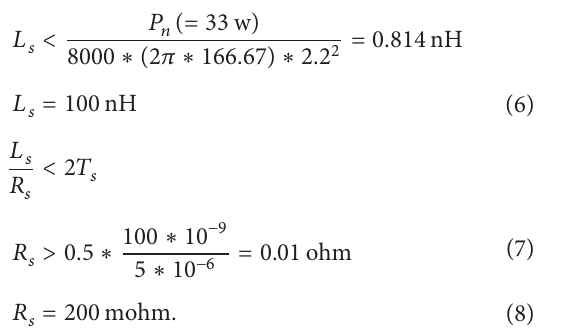
Figure 19: The 3-phase motor currents (with LCL filter and capacitor bank).